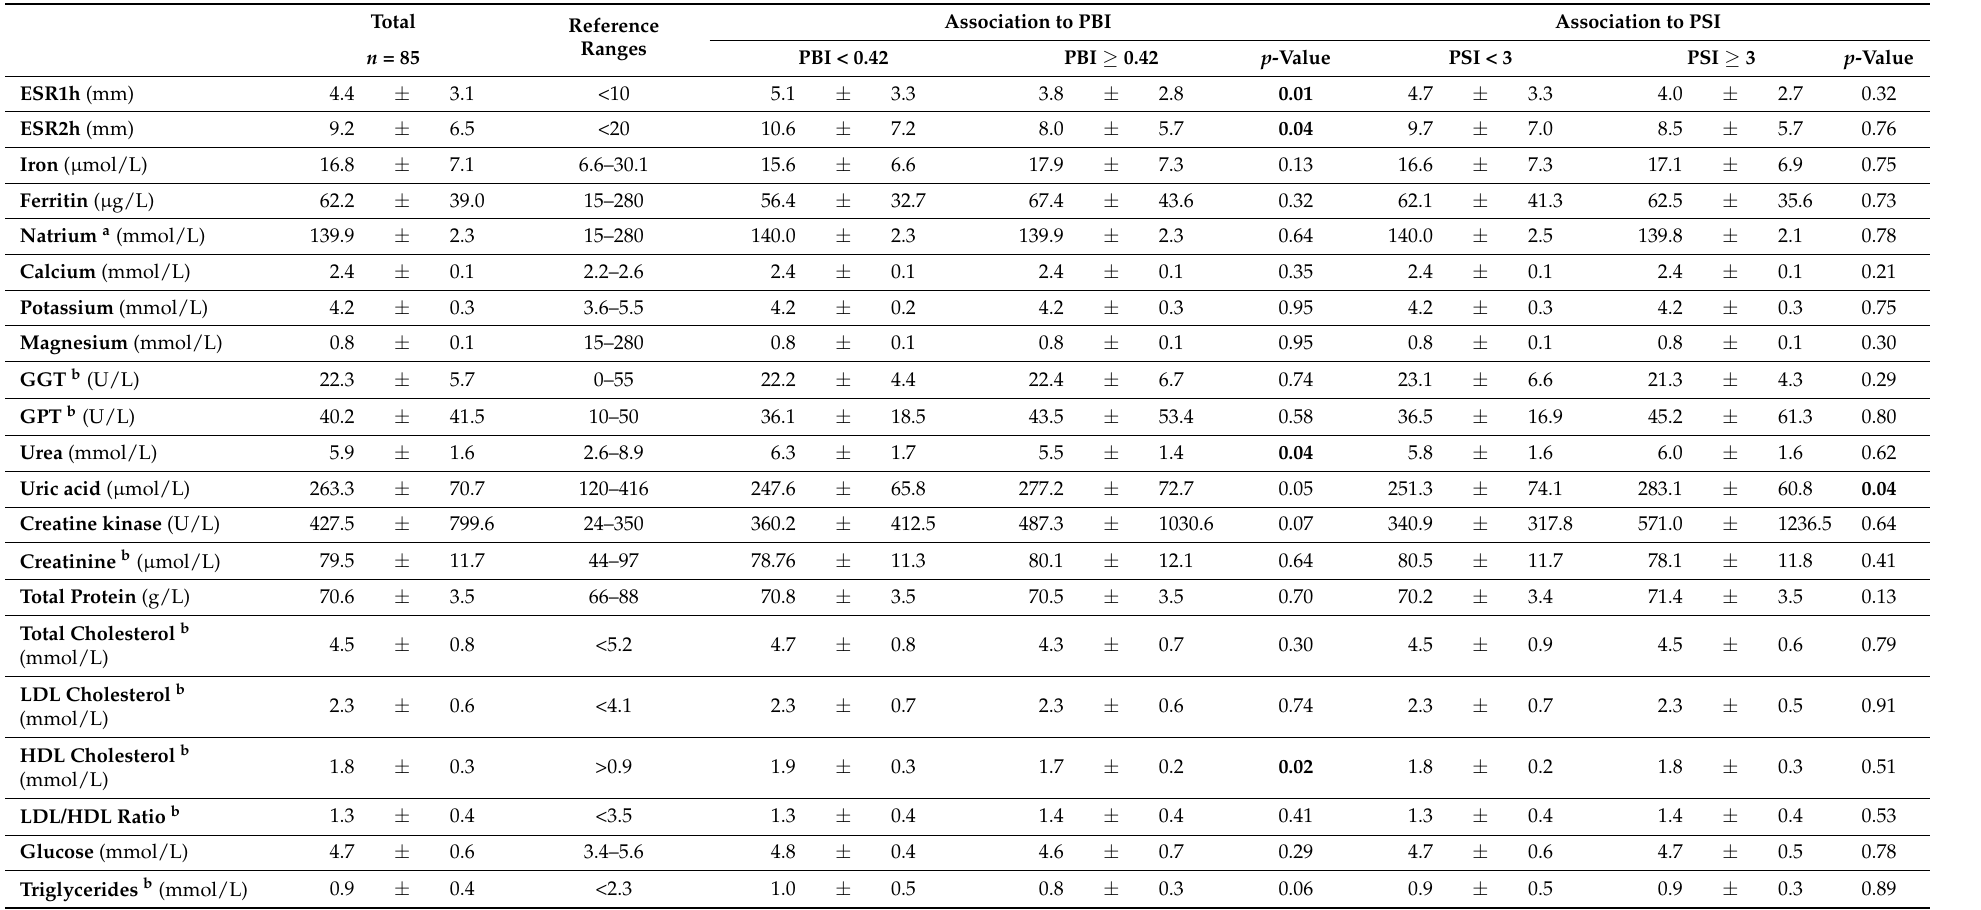
Table 4. Further blood parameters of the athletes (entire cohort) and their associations to with periodontal health (PBI and